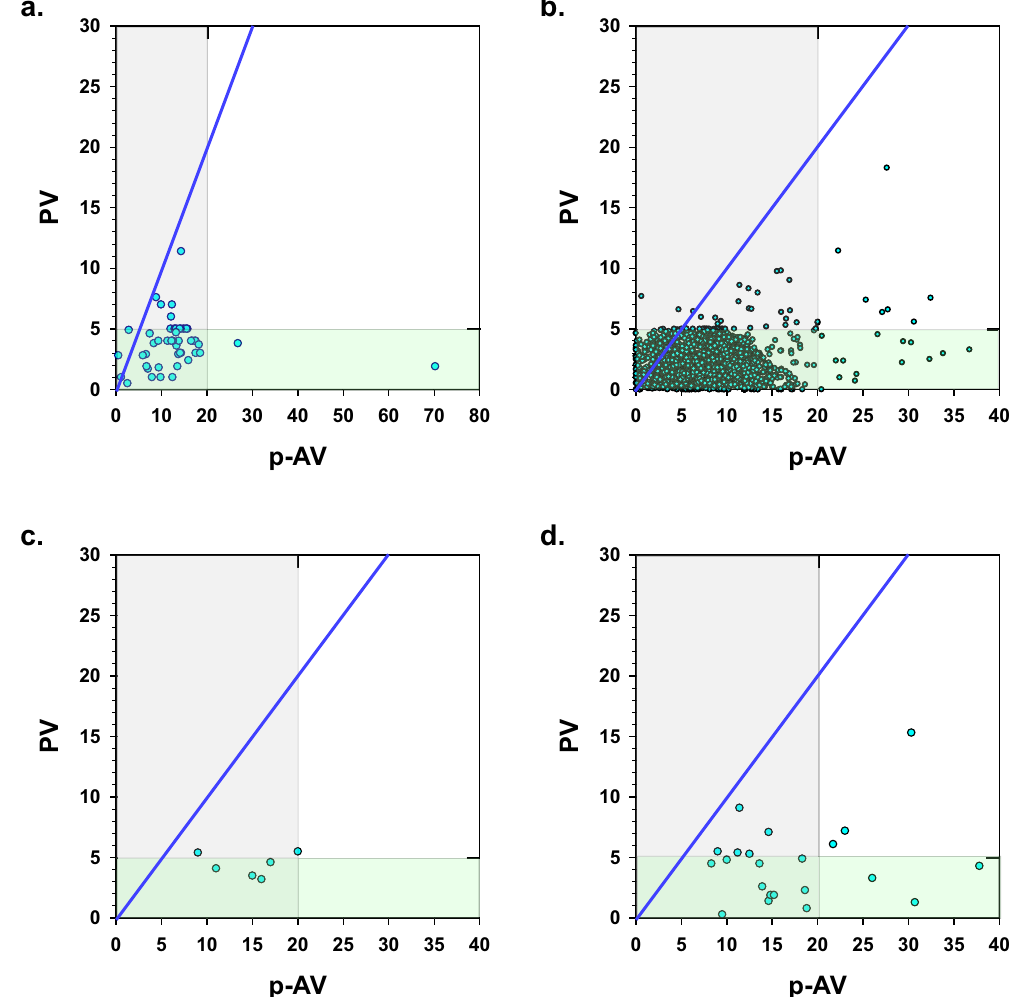
Figure 2. PV/p-AV ratios of fish oil products tested by third-party test organizations (panel a: LabDoor.com, panel b: IFOS; note, axis scales and symbols changed to improve visibility of data points) and reported in published literature (panel c: Turner et al . 33 , panel d: Madsen & Dyerberg, 1990 34 ). The green- and grey-shaded areas fall below the GOED maximum PV and p-AV limits of 5 meq O 2 /kg and 20, respectively. The blue line represents a PV/p-AV ratio of